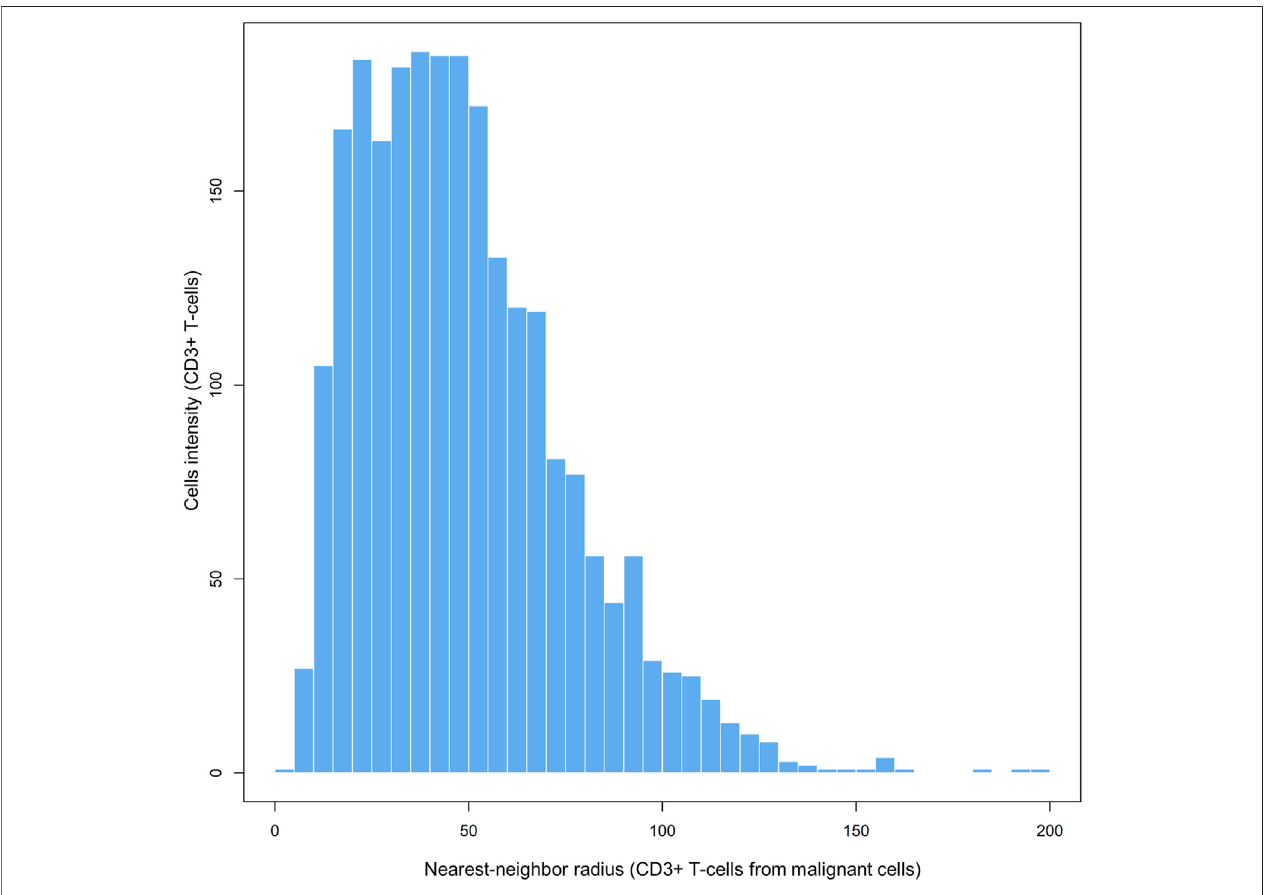
FIGURE 7 | Bar graph showing the distribution of CD3 + T-cell distances from malignant cells across different radii, from representative data extracted from a lung adenocarcinoma sample. The graphic was generated using R studio software version 3.6.1.